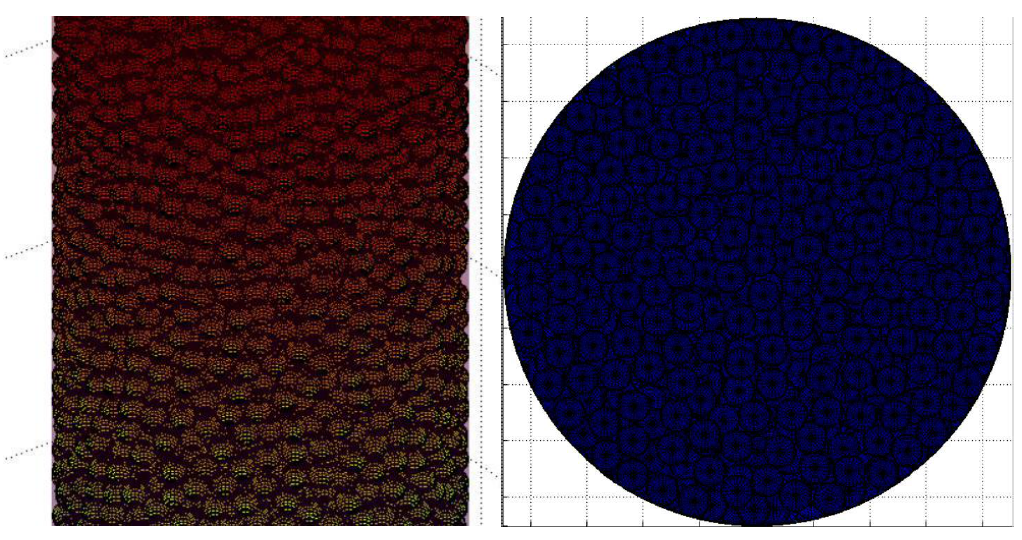
Figure 2. TRISO fuel distribution for PF = 45%.